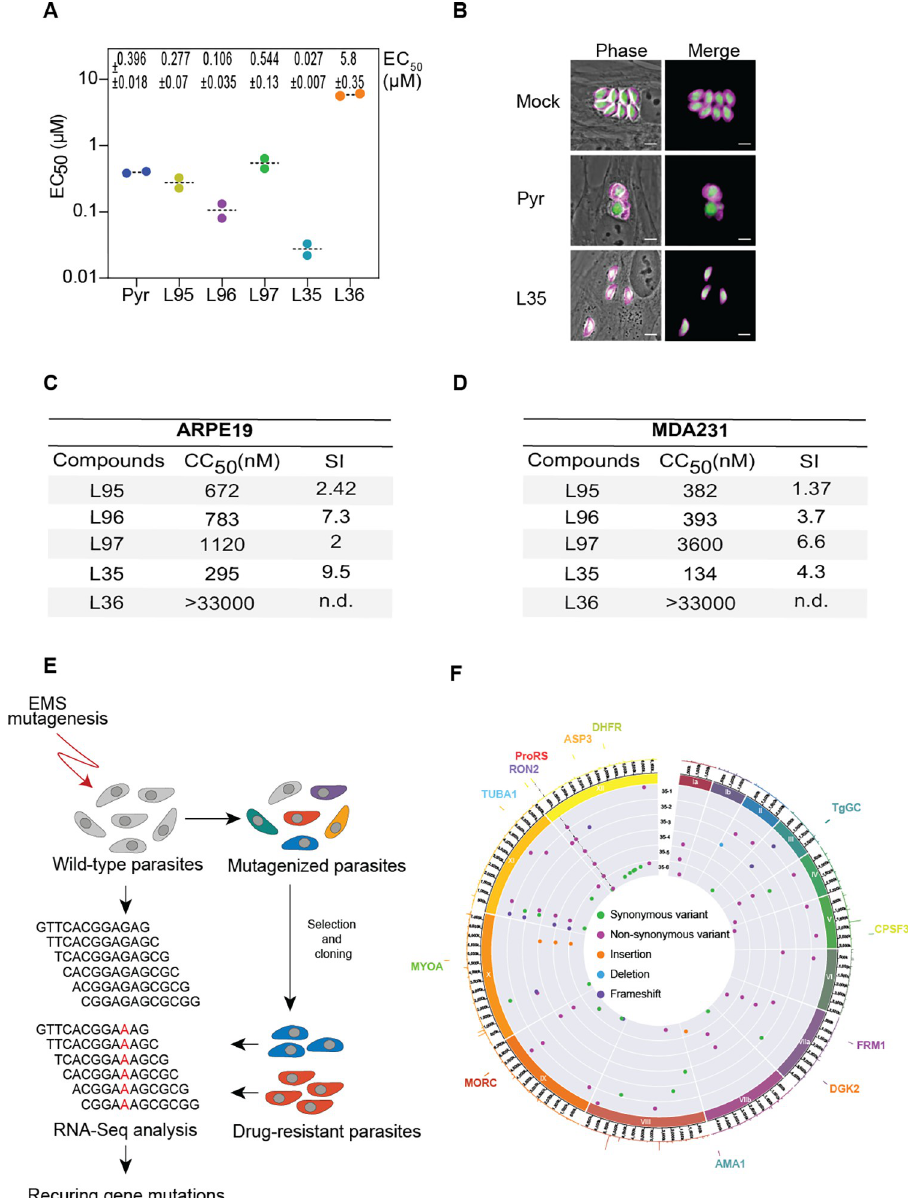
Fig 2. Efficiency of the five PPL-derivatives on Toxoplasma gondii parasite. A) EC 50 values for the indicated compounds were determined in vitro using T . gondii tachyzoites (RH Δ ku80 UPRT :: NLuc-P2A-EmGFP ). Data are mean ± SD of at least 2 independent biological replicates, each with 3 technical replicates. The corresponding dose- response curves are shown in S1A Fig B) IFA showing the efficiency of the L35 compound. HFFs were infected with tachyzoites (RH Δ ku80 UPRT :: NLuc-P2A-EmGFP ) and incubated with 1 μ M of pyrimethamine, 0.1 μ M of L35 or 0.1% DMSO as control. Cells were fixed 24 h post-infection and then stained with antibodies against the T . gondii inner membrane complex protein GAP45 (magenta). The cytosolic GFP is shown in green. Scale bars, 5 μ m. C-D) The Selectivity Index (SI) of the five PPL-derivatives was determined using the cell lines (C) ARPE19 (epithelial cells) and (D) MDA321 (breast cancer). Cells were incubated with increasing concentrations of drugs for 72 h. The viability of the human cell lines was determined to calculate the cytotoxicity concentration of the cells, CC 50 . SI values, presented in the tables, are based on the human cells CC 50 divided by the T . gondii EC 50 . No inhibition was detected for L36 compound. n.d., not detected. Associated dose-response curves are showed in S1 Fig. E) The diagram shows the strategy for L35 target deconvolution. The workflow is based on forward genetic screen using chemically induced resistant mutant lines. EMS-mutagenized parasites were then selected with lethal concentrations of L35. The resistant parasites along with the wild-type strain were analyzed by RNA-seq for computational analysis of the variants to